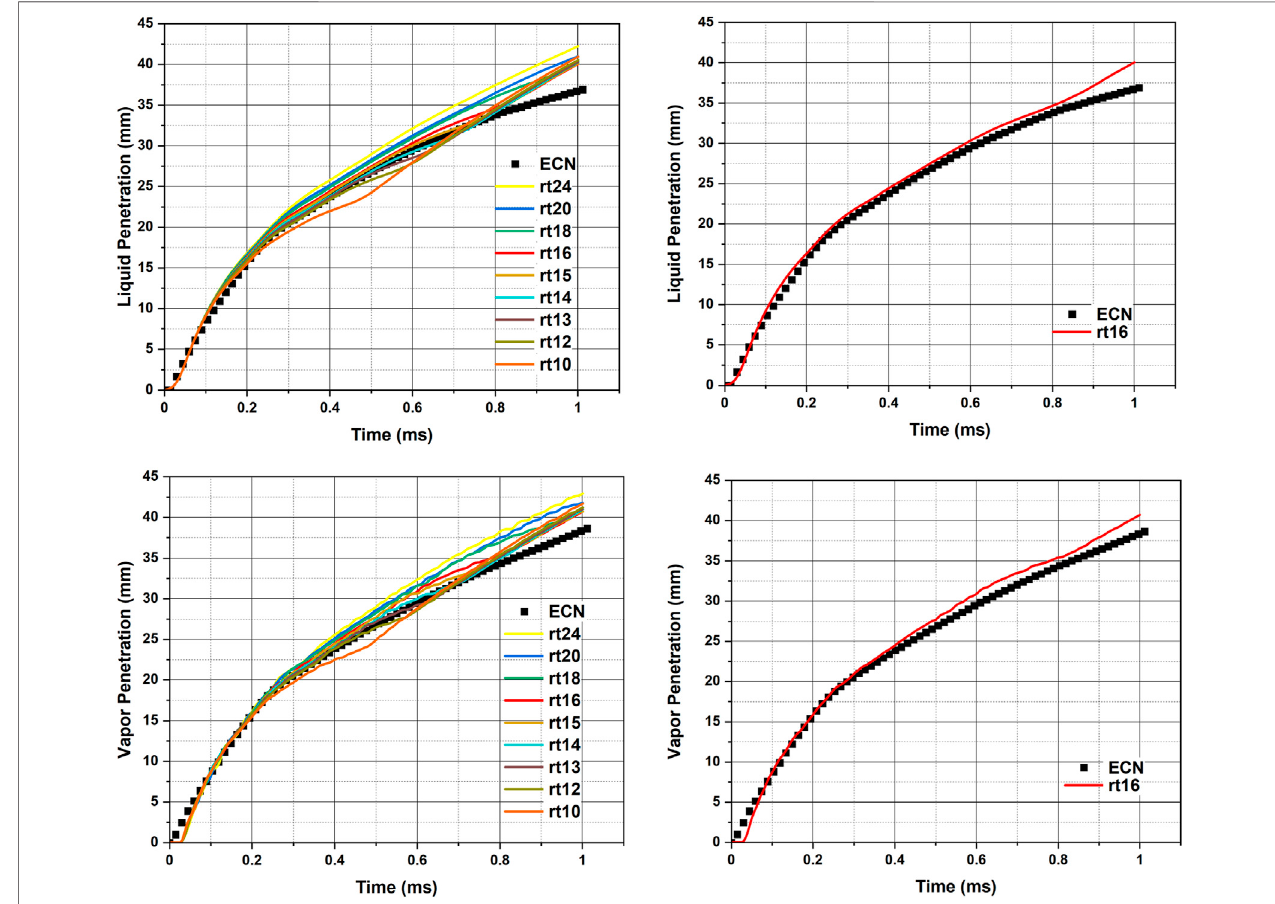
FIGURE 6 | Comparison of model predictions of liquid and vapor penetrations with the latest data measured by Sandia National Laboratories, available on ECN (ECN, 2022b)withRNGk – ε turbulence modelanddifferentbreakupmodel constants (rt10tort24) [ C bl (cid:2) 10representedasrt10;for C bl =10orrt10, thebreakuptime constant B 1 will be 2* C bl which is B 1 (cid:2) 20; cone-angle 25 ° , plume targeting angle 35 ° ].